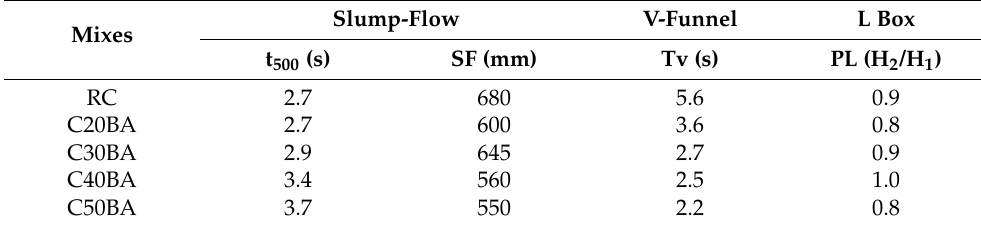
Table 4. Fresh concrete properties, slump-flow, V funnel and L